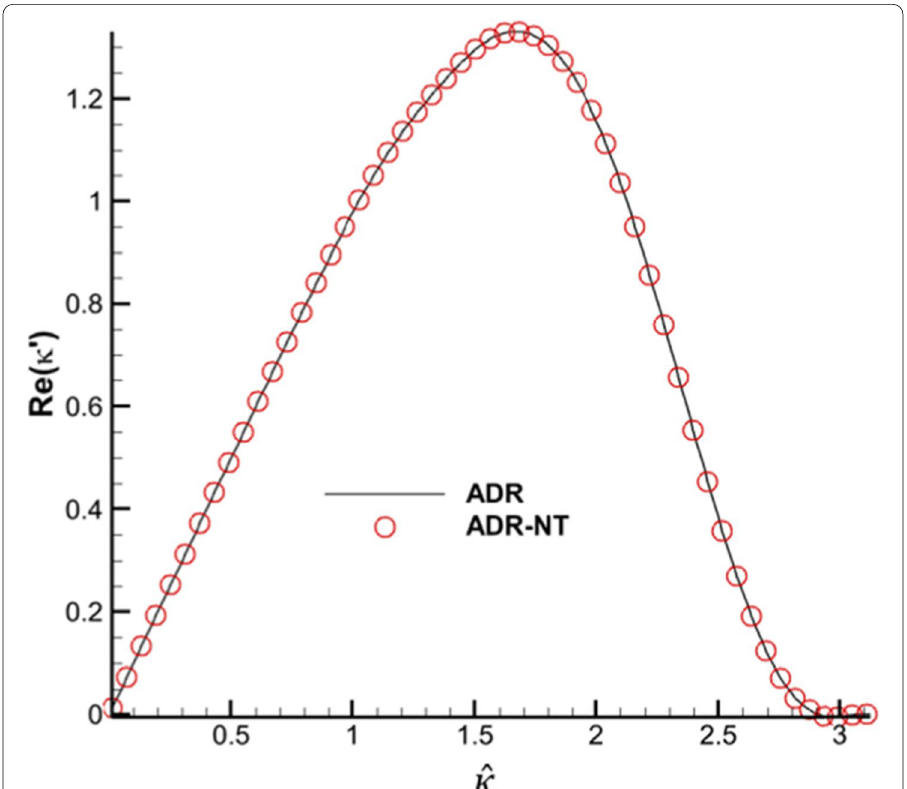
Fig. 1 Re( κ ′ ) of WENO5-JS by ADR and ADR-NT respectively, where N x